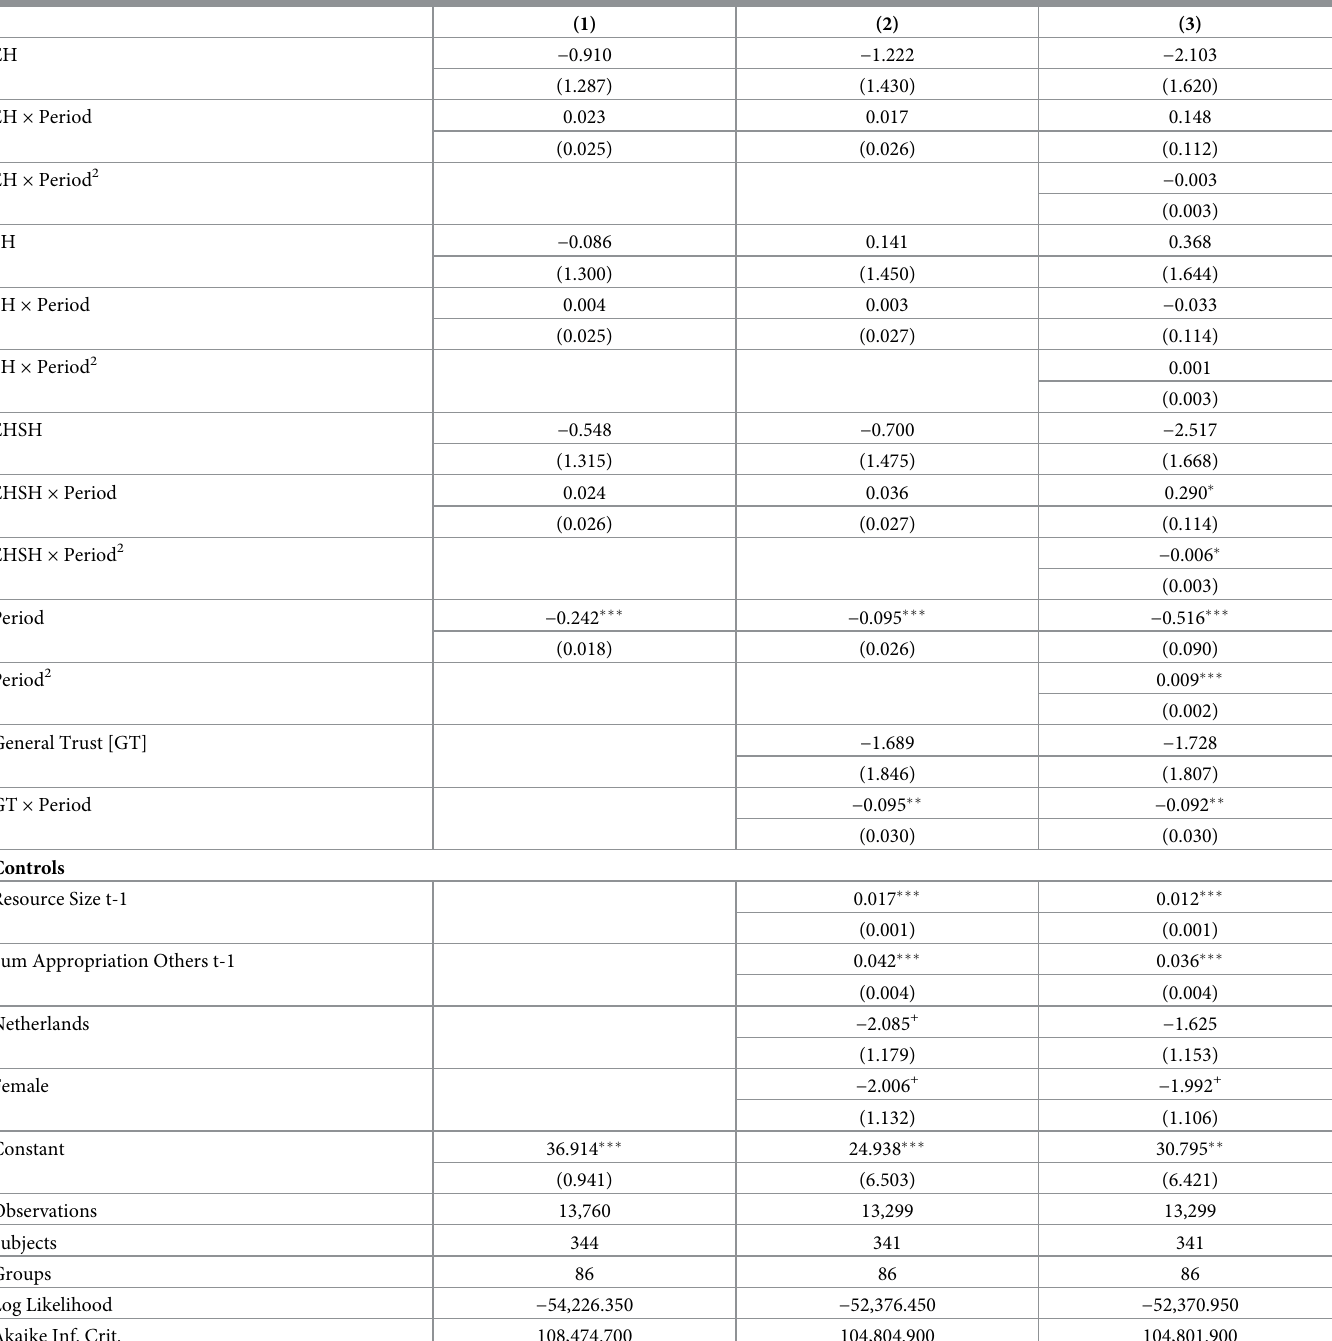
Table 4. Three-level multilevel regression on appropriation effort with random intercepts for subjects and